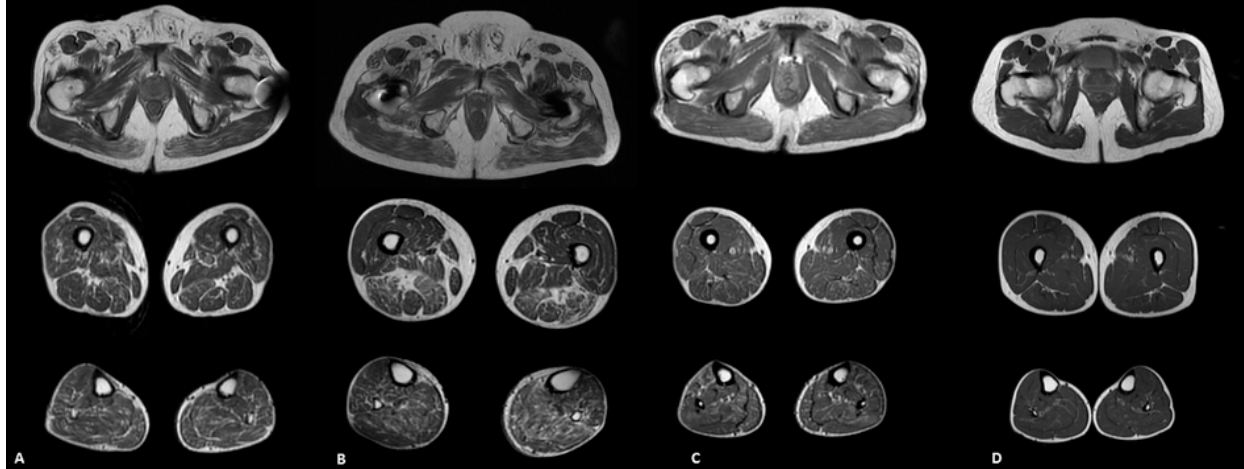
Figure 1. Muscle MRI pattern of fatty infiltration in ATTRv patients (#2 in ( A ); #6 in ( B ); #1 in ( C )) and in a healthy subject ( D ). Tensor fascia latae and soleus were the most frequently involved muscles, with relative sparing of the iliopsoas, rectus femoris, gracilis and anterior tibilias muscles ( A , B ); in only one case the anterior tibialis presented an asymmetric severe adipose substitution ( C ). No fatty replacement was found in healthy subject ( D ).